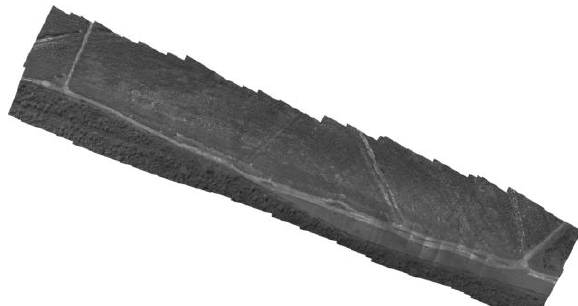
Figure 10. Mosaic generated with the spectral band ( 605.64 nm , sensor 2) in study. Some radiometric effects can be realized due to the illuminarion variation during the flying